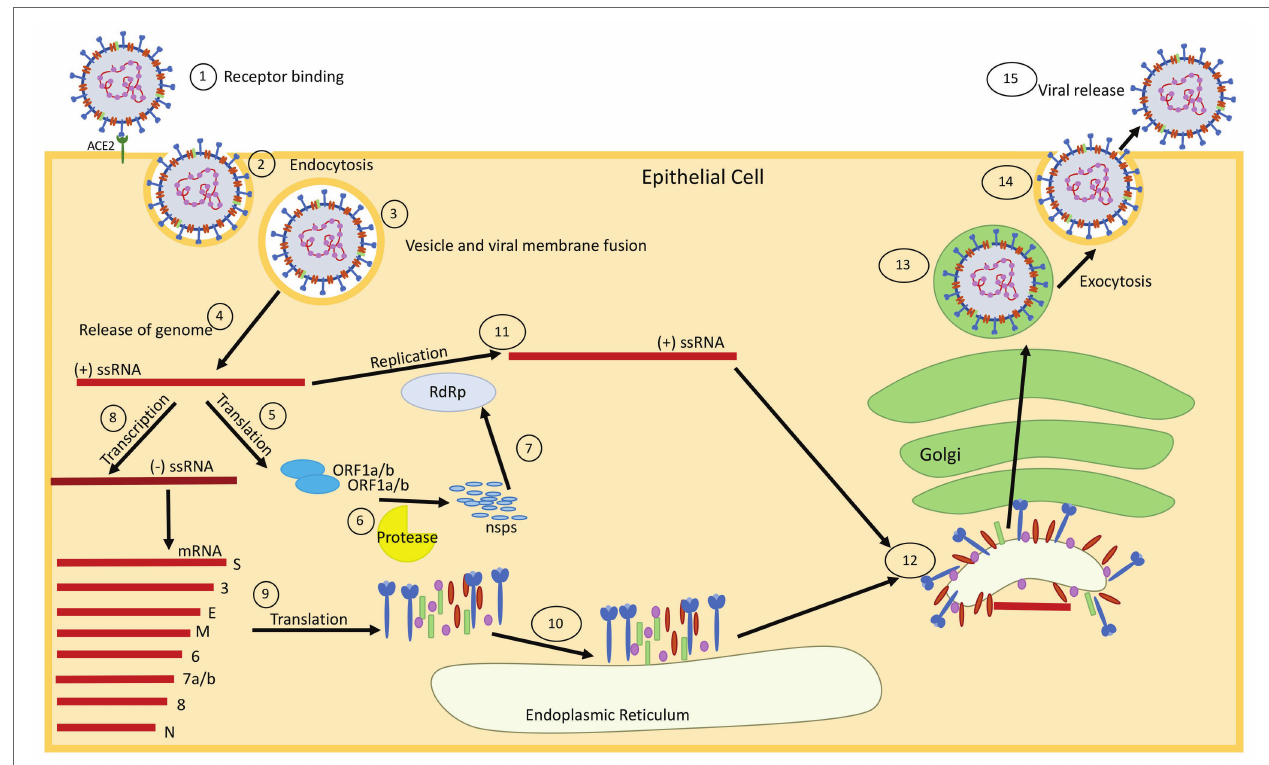
FIGURE 1 | Schematic diagram showing the replication cycle of SARS-CoV-2. (1) SARS-CoV-2 binds to epithelial cells via the ACE2 receptor. (2) The virus enters the cell via ACE2 mediated endocytosis. (3) The virus membrane and endosome membrane fuse (4) releasing the positive-sense (+) single-stranded RNA (ssRNA) genome into the cytoplasm. (5) The genome is translated to produce ORF1a and ORF1b proteins. (6) These proteins are cleaved into 16 non-structural proteins (nsps) by papain-like protease in a process called proteolysis. (7) The nsps are used to make an RNA-dependent RNA-polymerase (RdRp), which will help with replication of the genome. (8) The original (+) ssRNA genome is also transcribed into negative-sense ( − ) ssRNA, which is then transcribed into mRNA. (9) The mRNA is translated into the respective structural proteins that (10) gather at the endoplasmic reticulum (ER). (11) The genome is then replicated at full-length, with the help of the RdRp, and assembles with the proteins at the Golgi for packaging. (12) The proteins bud from the ER using the ER membrane (which will become the viral membrane), and migrate to the Golgi apparatus, where the viral package is transported through the Golgi and assembled for (13 and 14) exocytosis. (15) The fully formed virus is then released from the cell